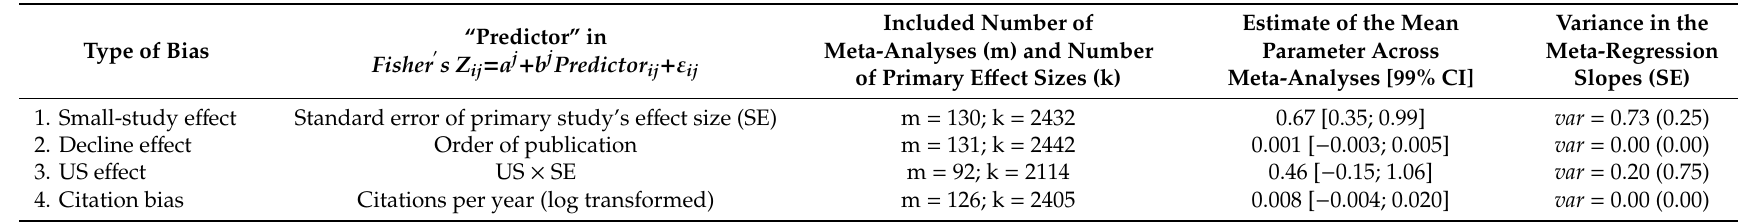
Table 4. Overview of the meta-meta-regressions we estimated in this paper to investigate di ff erent predictors for e ff ect size that could potentially indicate bias. We estimated these bias-related patterns in five separate